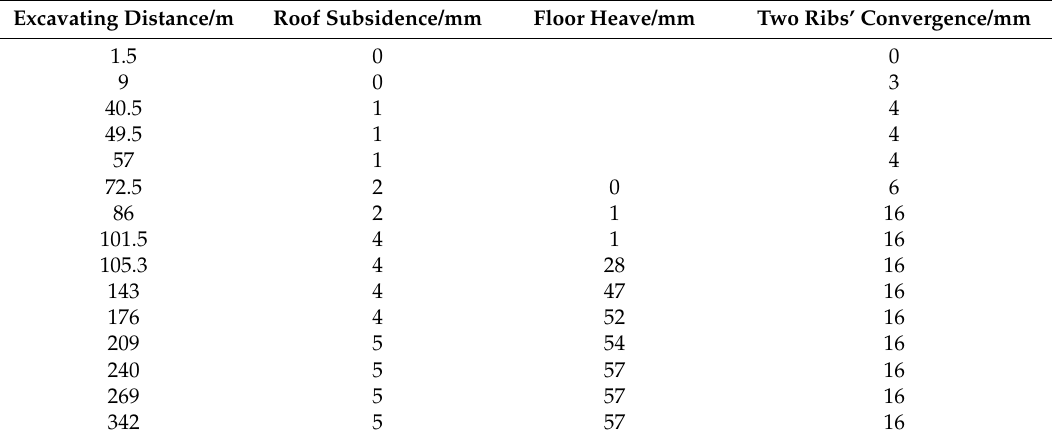
Table 4. Deformation variation of the roadway with roadway